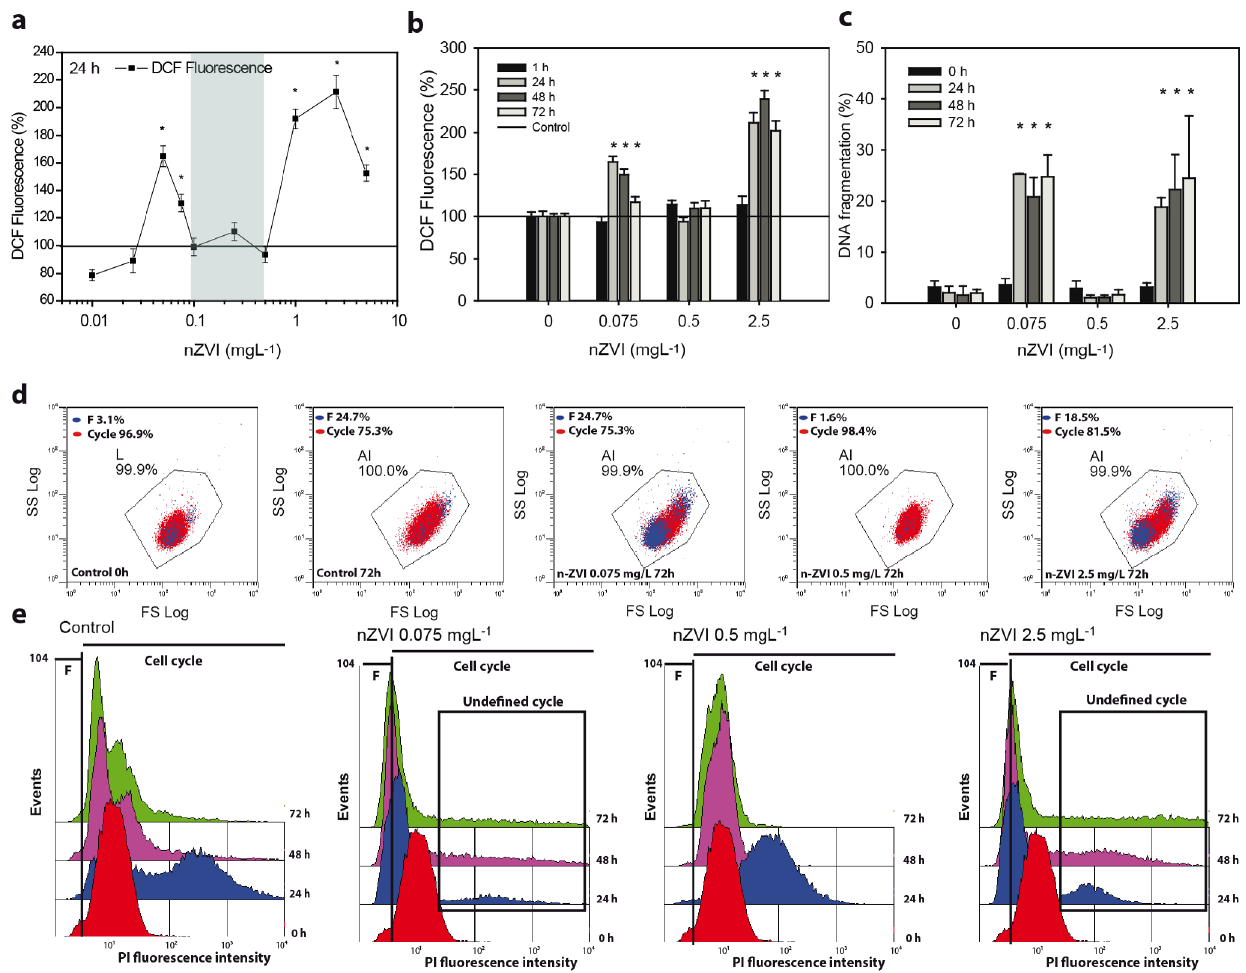
Figure 4. nZVI toxicity is consistently accompanied by ROS and cell cycle alterations. (a) Intracellular ROS formation as DCF fluorescence (% with respect to control levels) of P. subcapitata to an nZVI dose gradient (0.025–5 mgL 2 1 ) at 24 h of exposure. The concentration range in which the colloidal singularity occurred is marked in blue. (b) Intracellular ROS formation as DCF fluorescence (% with respect to control levels) and (c) % of P. subcapitata cells showing DNA fragmentation, when exposed to representative nZVI concentrations (0, 0.075, 0.5, 2.5 mgL 2 1 ) at relevant exposure times (0 h, 24 h, 48 h and 72 h). (d) Representative FS-SS distribution plots of P. subcapitata cells exposed to 0, 0.075, 0.5, 2.5 mgL 2 1 nZVI at relevant exposure times (0 h, 24 h, 48 h and 72 h). Red dots depict cells undergoing cell cycle progression, and blue dots depict cells showing DNA fragmentation (e) Representative cell cycle frequency histograms of P. subcapitata cells exposed to 0, 0.075, 0.5, 2.5 mgL 2 1 nZVI at relevant exposure times (0 h, 24 h, 48 h and 72 h). F: cell population containing less DNA than G0/G1 phase, which denoted a cell population showing DNA fragmentation. Black chart: cell population undergoing an abnormal cell cycle (poorly defined S and G2/M phases). Statistically significant differences ( p , 0.05) are marked by